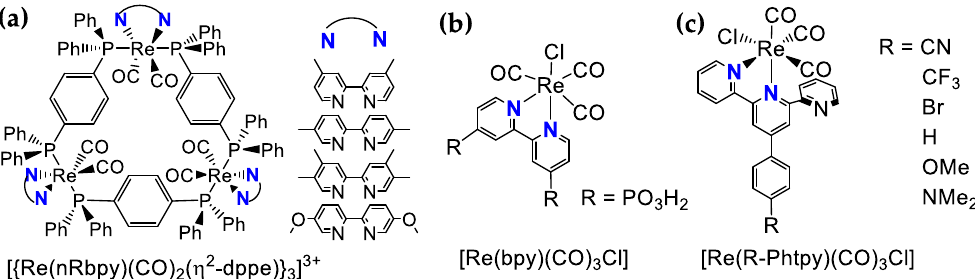
Figure 6. Chemical structures of the ( a ) Rhenium(I) trinuclear -based, ( b ) [Re(4,4′-PO 3 H 2 - bpy)(CO) 3 Cl]-based, and ( c ) Rhenium(I) tricarbonyl photosensitizers in this review.